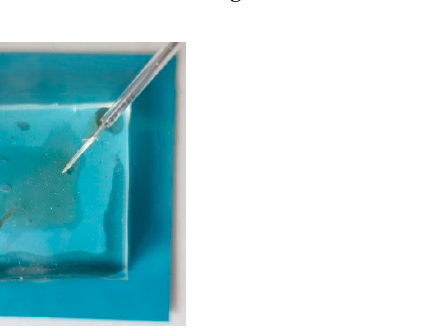
Figure 7. A view of the test microfluidic deice, before ( left ) and after ( right ) filling with methyl orange. An irregular bonding area can be observed, although the structure was hermetic.